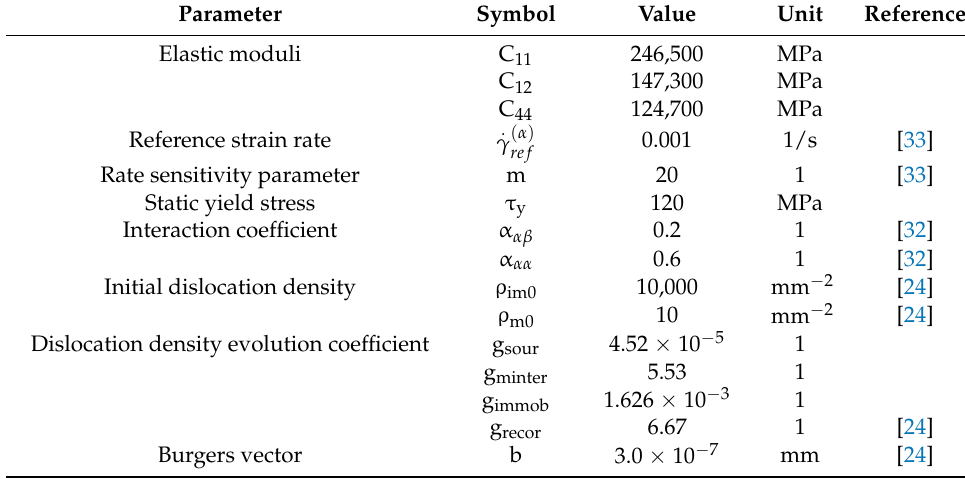
Table 3. Material parameters used in the crystal plasticity finite element simulations.